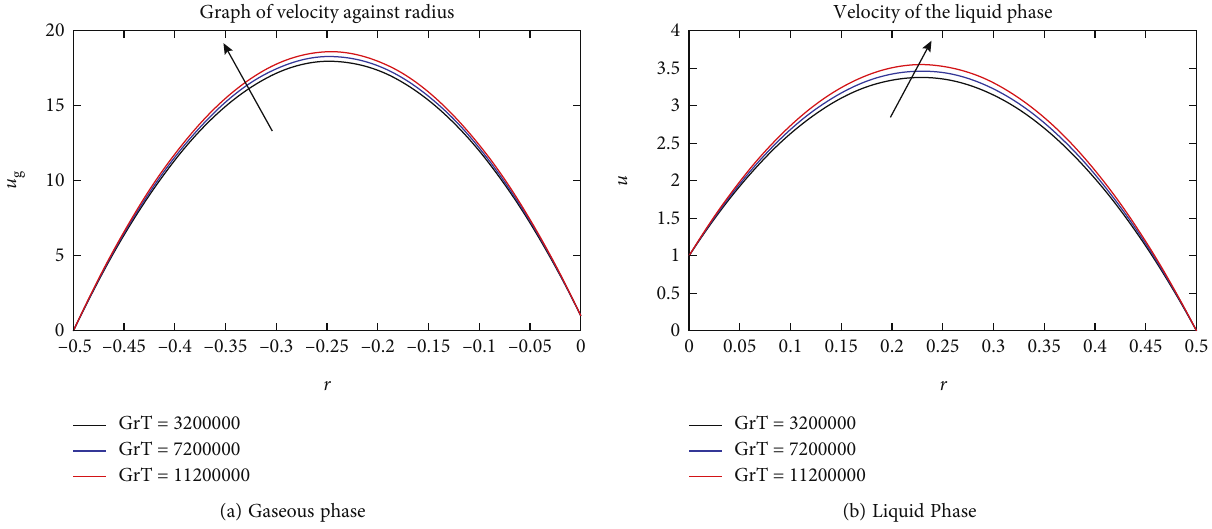
Figure 4: E ff ects of Grashof Thermal Number on Velocity.